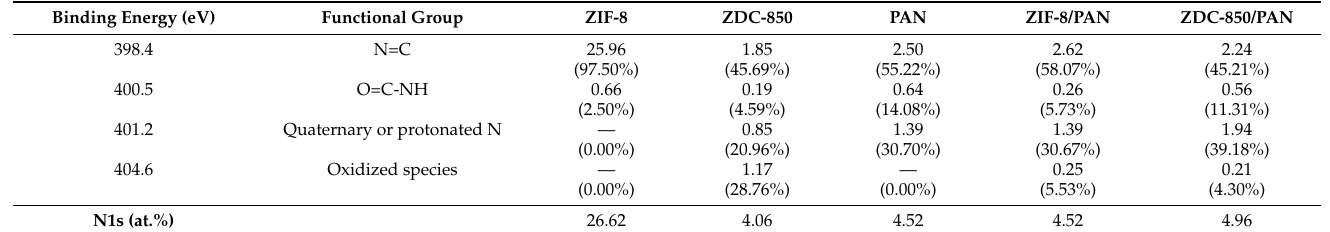
Table 2. Results of the fit of the XPS N 1s region; values given in at.% (percentage of total inten- sity).